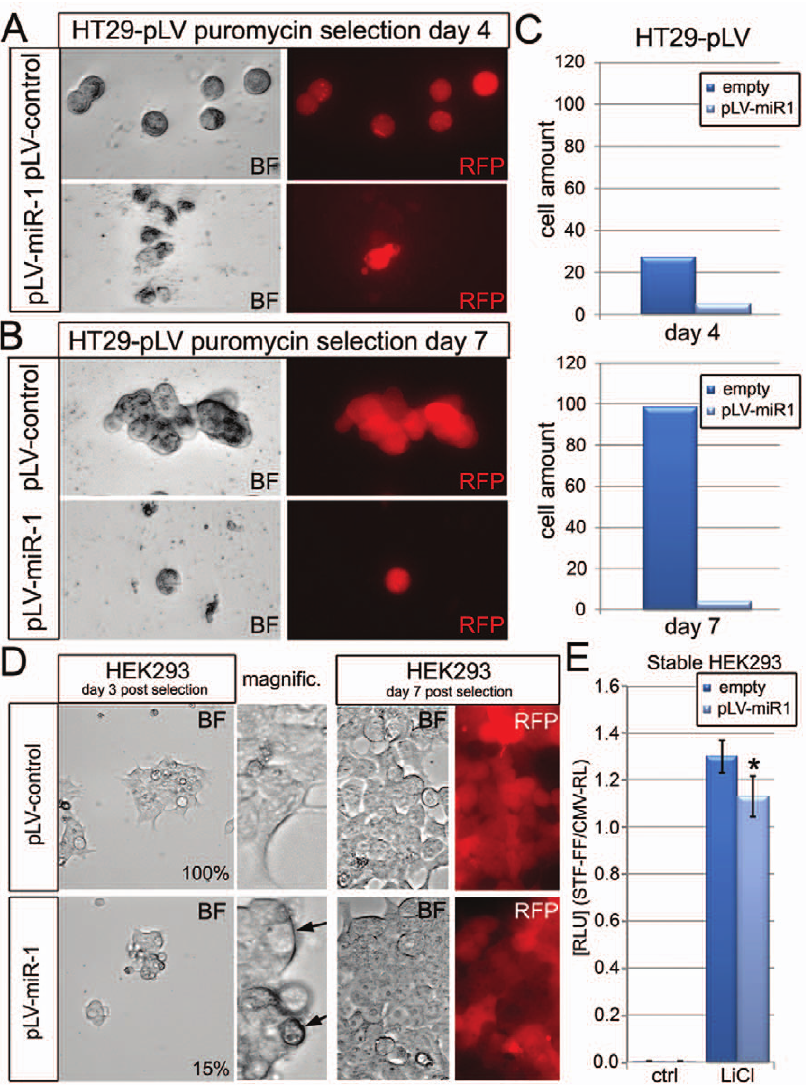
Figure 4. Characterization of miR-1 overexpression in HT29 and HEK293 cells. (A) HT29 colon cancer cells expressing pLV-Hsa-Pre-miR-1 or control vectors at day 4 of puromycin selection. (B) HT29 cells expressing pLV-Hsa-Pre-miR-1 or control at day 7 of puromycin selection. (C) Quantification of HT29 cells at day 4 and 7. RFP (red) fluorescence indicates the expression of RFP harboring the intronic miR-fragment. (D) HEK293 cells expressing miR-1 or control at day 3 (left) and day 7 (right) post puromycin selection. RED RFP fluorescence indicates expressing HEK293 cells. (E) LiCl induced Wnt pathway activity in stable miR-1expressing HEK293 cells.